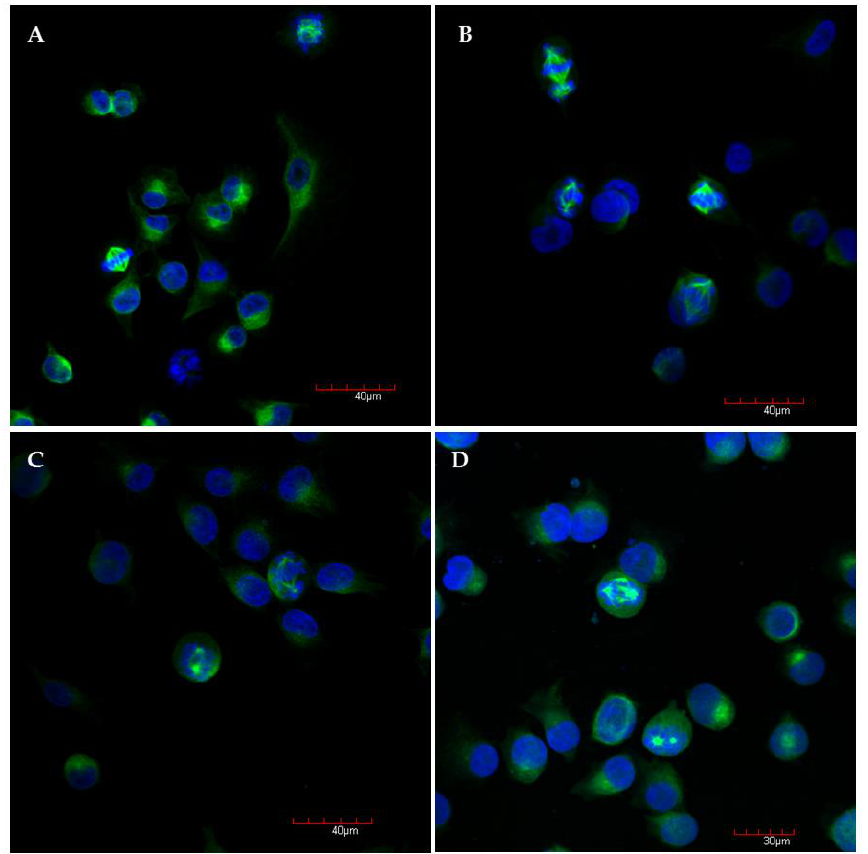
Figure 4. Representative confocal microscopy images of A375 cells after 6 h incubation with medium and 0.2% DMSO ( A ), compound S1 ( B ), S19 ( C ), S22 ( D ) at concentration of 10 µM, with stained α-tubulin (green) and chromosomes (blue); magnification ×20 plus zoom ×3 during acquisition.